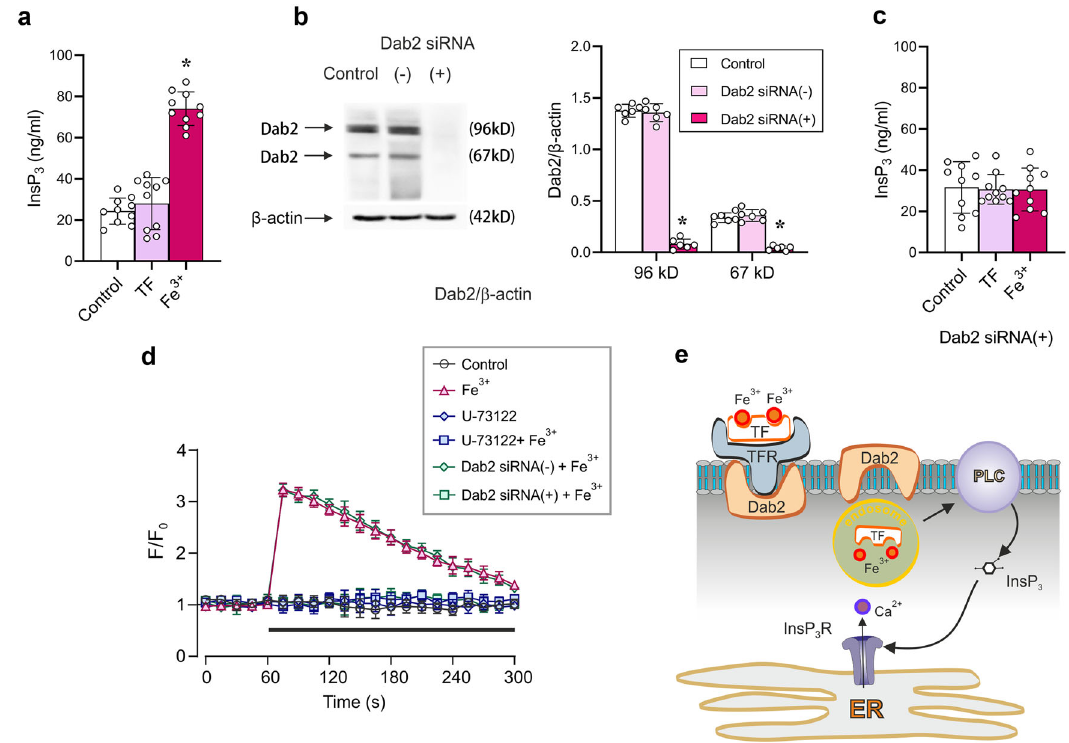
Fig. 6 Mechanisms of Fe 3 + induced Ca 2 + signalling. a Incubation with Fe 3 + increases InsP 3 level in cultured astrocytes; InsP 3 was measured with ELISA; data are presented as mean ± SD, n = 10. *Indicates statistically signi fi cant ( p < 0.05) difference from any other group. b Representative protein bands for two isoforms (96 KDa and 67 KDa) of Dab2 in cultured astrocytes treated with sham (Control), siRNA negative control ( − ) or positive duplex chains ( + ). Protein values are shown as the ratio of 96 kDa isoform and β -actin (42 kDa), and the ratio of 67 kDa isoform and β -actin. Data represent mean ± SD, n = 6. *Indicates statistically signi fi cant ( p < 0.05) difference from any other group. c Fe 3 + -dependent changes in the InsP 3 after treatment with Dab2 siRNA duplex chains. After treatment with Dab2 siRNA duplex chains ( + ) for 3 days, the primary cultured astrocytes were treated with serum-free medium (Control), TF (as negative control) or 10 μ M Fe 3 + -TF (Fe 3 + ) for 5 minutes, the level of InsP 3 was measured by ELISA and shown as mean ± SD, n = 10. d Fe 3 + -induced [Ca 2 + ] i responses are Dab 2 and PLC dependent. Treatment with Dab2 siRNA duplex chains ( + ) as well as with 10 μ M U-73122 (PLC inhibitor) suppressed Fe 3 + -induced [Ca 2 + ] i responses. Every data point represents mean ± SD, n = 10. e Mechanisms of Fe 3 + - induced Ca 2 + signalling in astrocytes. The uptake of Fe 3 + is mediated TFR, TFR internalization requires Dab2; when in the cytosol Fe 3 + activated PLC thus stimulating InsP3-induced Ca 2 + release from the